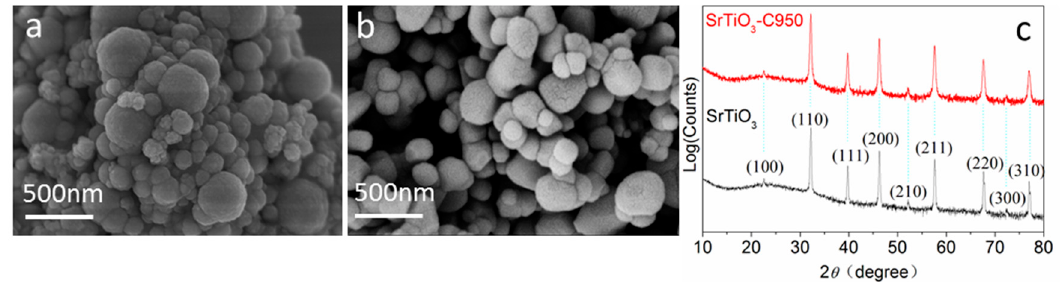
Figure 1. Morphology and Structure characterizations of SrTiO 3 . ( a ), Scanning Electron Microscope (SEM) image of SrTiO 3 ; ( b ), SEM of SrTiO 3 -C950; ( c ), XRD of SrTiO 3 and SrTiO 3 -C950.